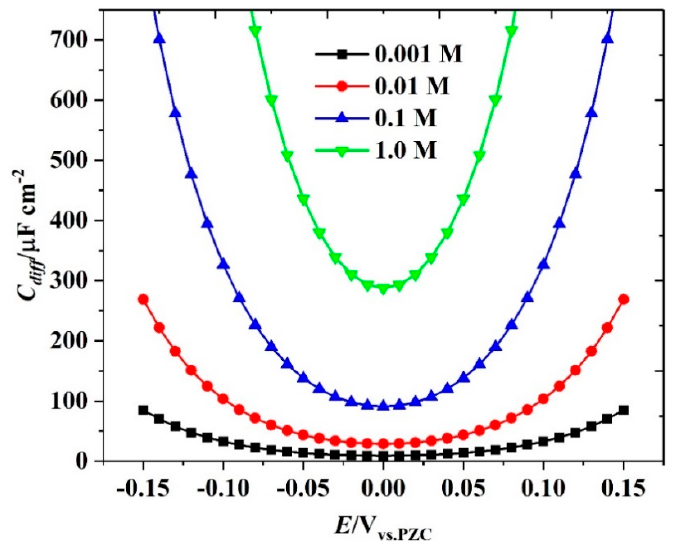
Figure 3. A plot showing the effect of electrolyte concentration on diffuse layer capacitance ( C diff ) with respect to the applied potential vs. potential zero charge (PZC), calculated from Equation (2) for mono valence ions.